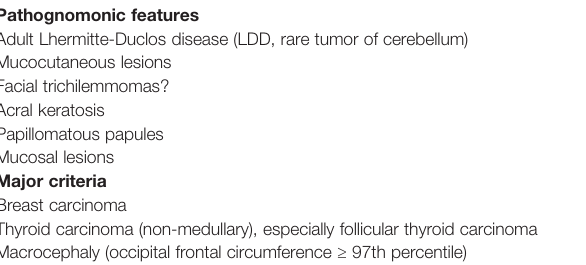
TABLE 4 | Cowden syndrome diagnostic criteria. Adapted from